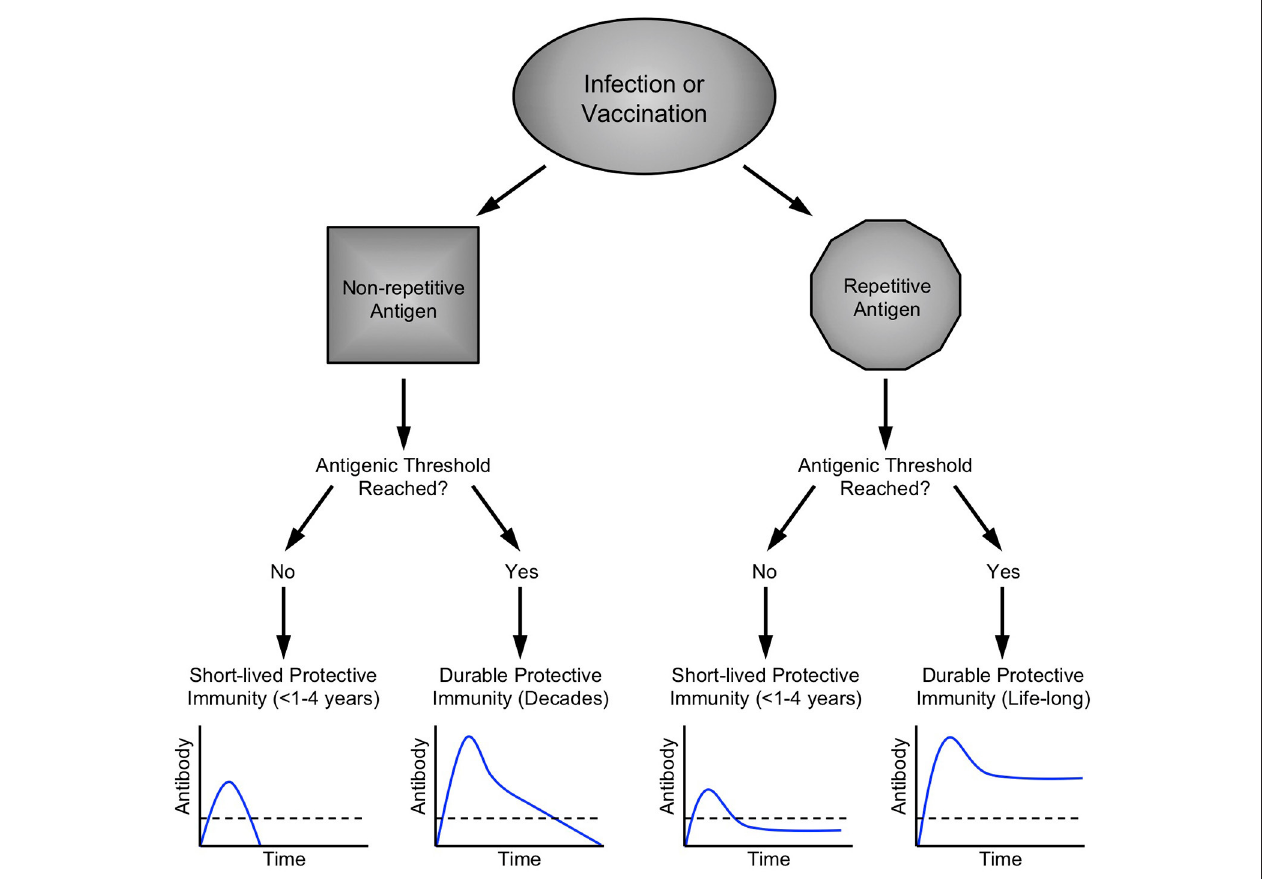
FIGURE 4 | Imprinted lifespan model of humoral immunity. Prior longitudinal studies have indicated that different vaccine and virus antigens elicit serum antibody responses of varying duration (58). Since long-lived PC are terminally-differentiated non-dividing cells that can survive for months or even years after the initial antigenic insult has been resolved ( 27), our hypothesis is that PC lifespan must be determined or “imprinted” at the time of B cell activation during the initial stages of an active immune response. Microbes such as viruses and bacteria have surface antigens that are highly repetitive and these structural attributes are likely to cause increased B cell activation by binding to multiple immunoglobulin molecules on the responsive B cell and trigger increased signal transduction in comparison to B cell activation induced by non-repetitive or monovalent antigens. B cell activation is further enhanced via T cell help during T-dependent immune responses to